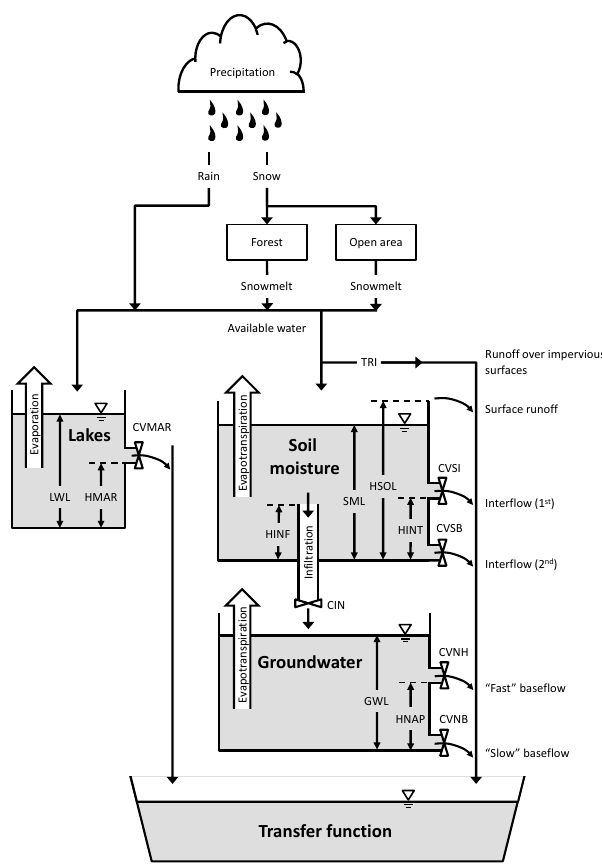
Figure 2. Diagram of the processes included in CEQUEAU’s pro- duction